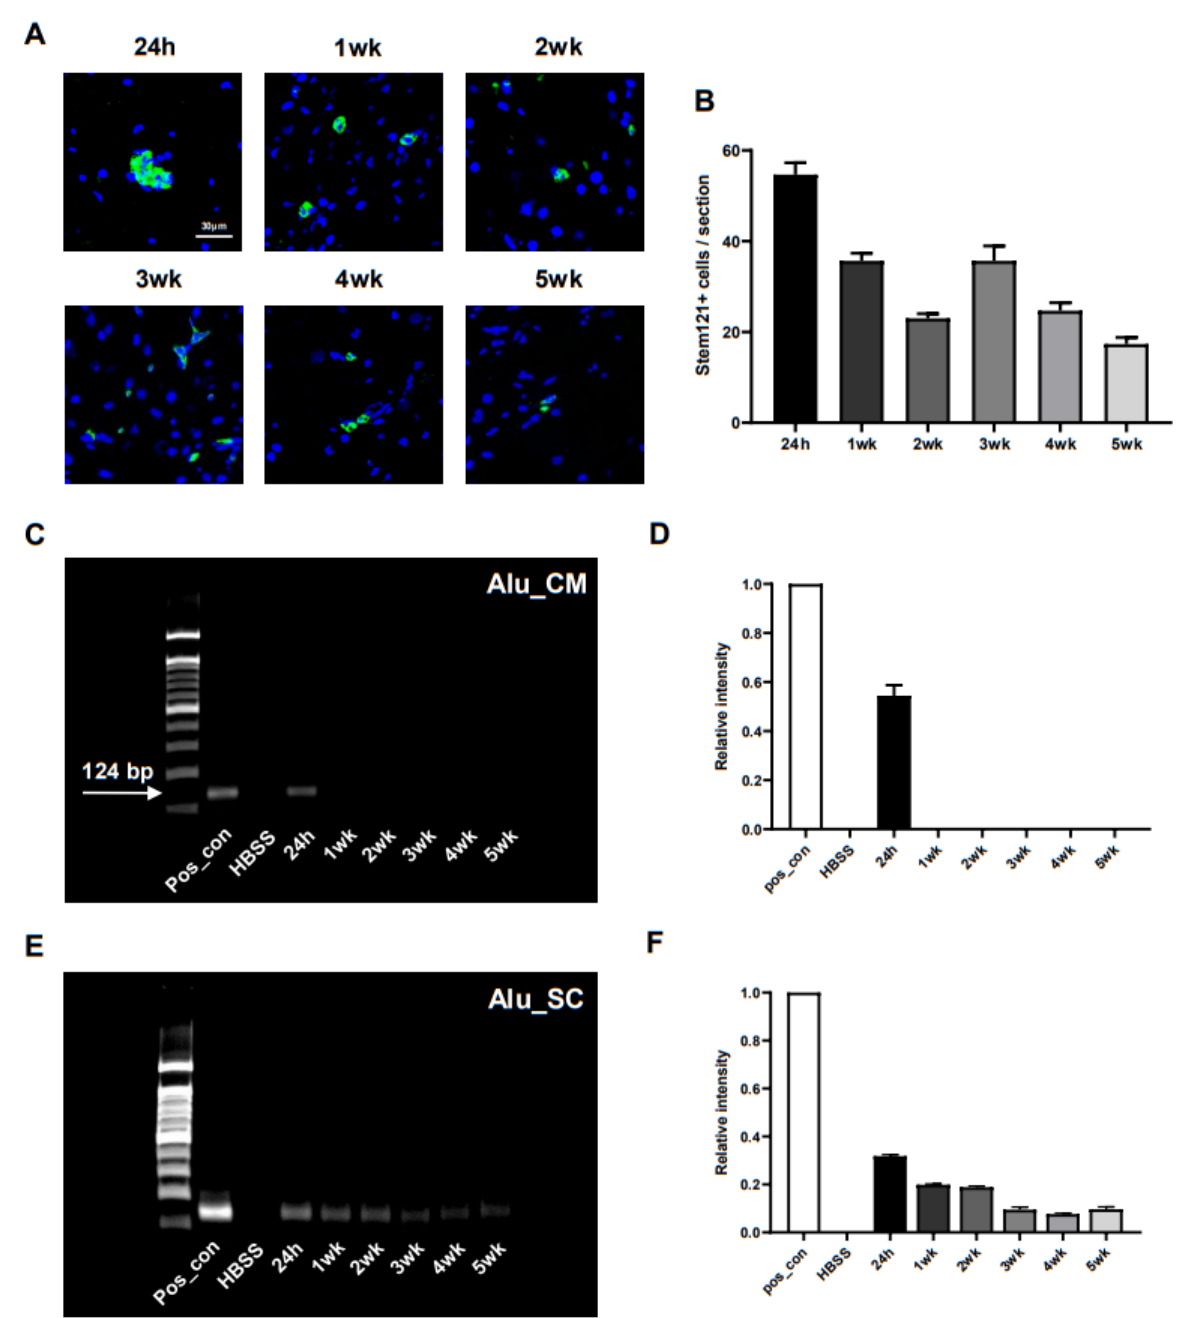
Figure 7. In vivo distribution of transplanted ahMNCs. ( A ) Immunohistochemistry allowed for the detection of ahMNCs which present with human cytoplasm (green). Blue = Nuclei. Scale bar = 30 µm. ( B ) The average number of human cells in three serially derived sections were quantified in each animal and then compared. ( C ) Human-specific Alu sequences (124 base pairs) were amplified from several brain tissues including the CM using PCR. ( D ) Relative intensities of the PCR products were quantified. ( C ) Human-specific Alu sequence was amplified by PCR in several tissues including the SCI lesion. ( D ) Relative intensities of the PCR products were quantified. Height = Average, Error bar = Standard Error.